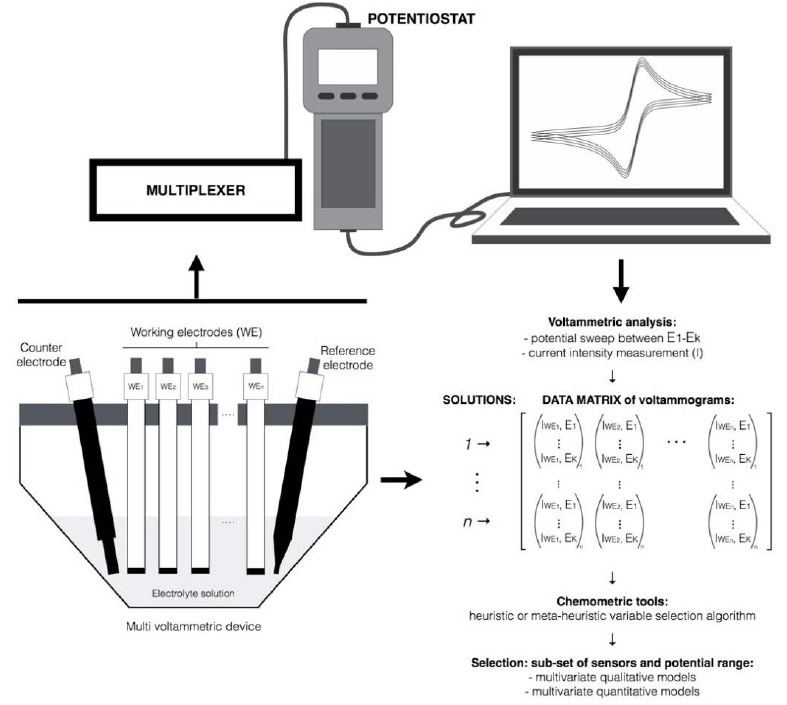
Figure 2. Database of signals profiles generated by a voltammetric E-tongue device comprising K working electrodes, during the analysis of M samples.